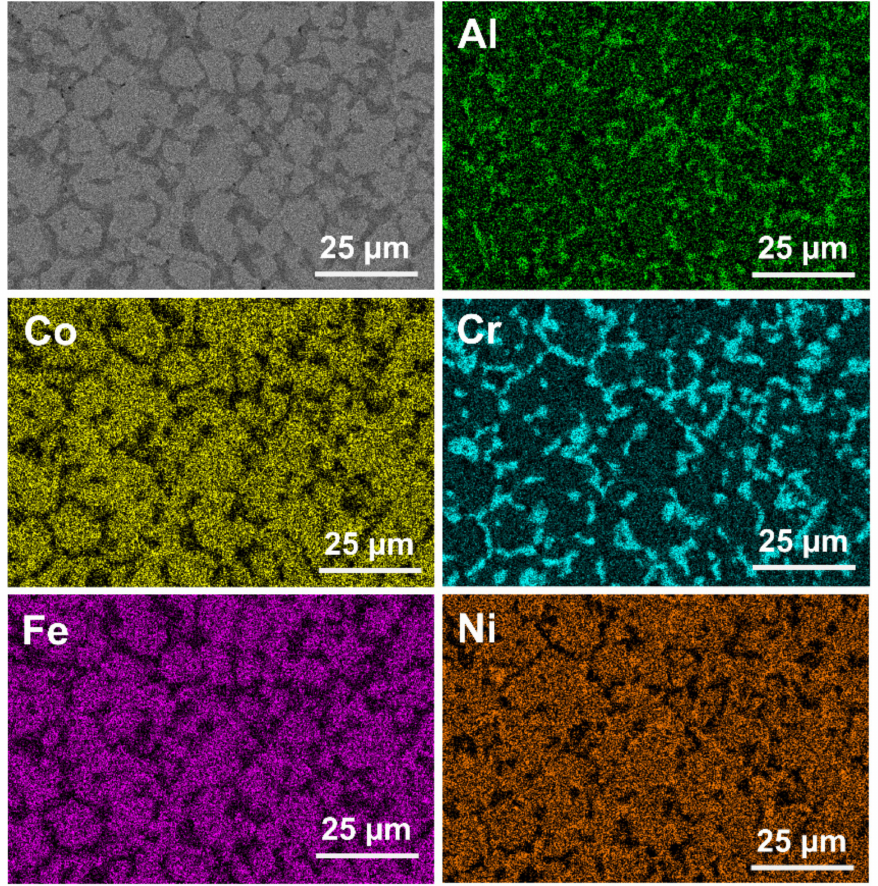
Figure 4. SEM scan results of AC samples. (Al and Ni map, B2 phase; Co, Fe, and Ni map, FCC phase; Cr map, BCC